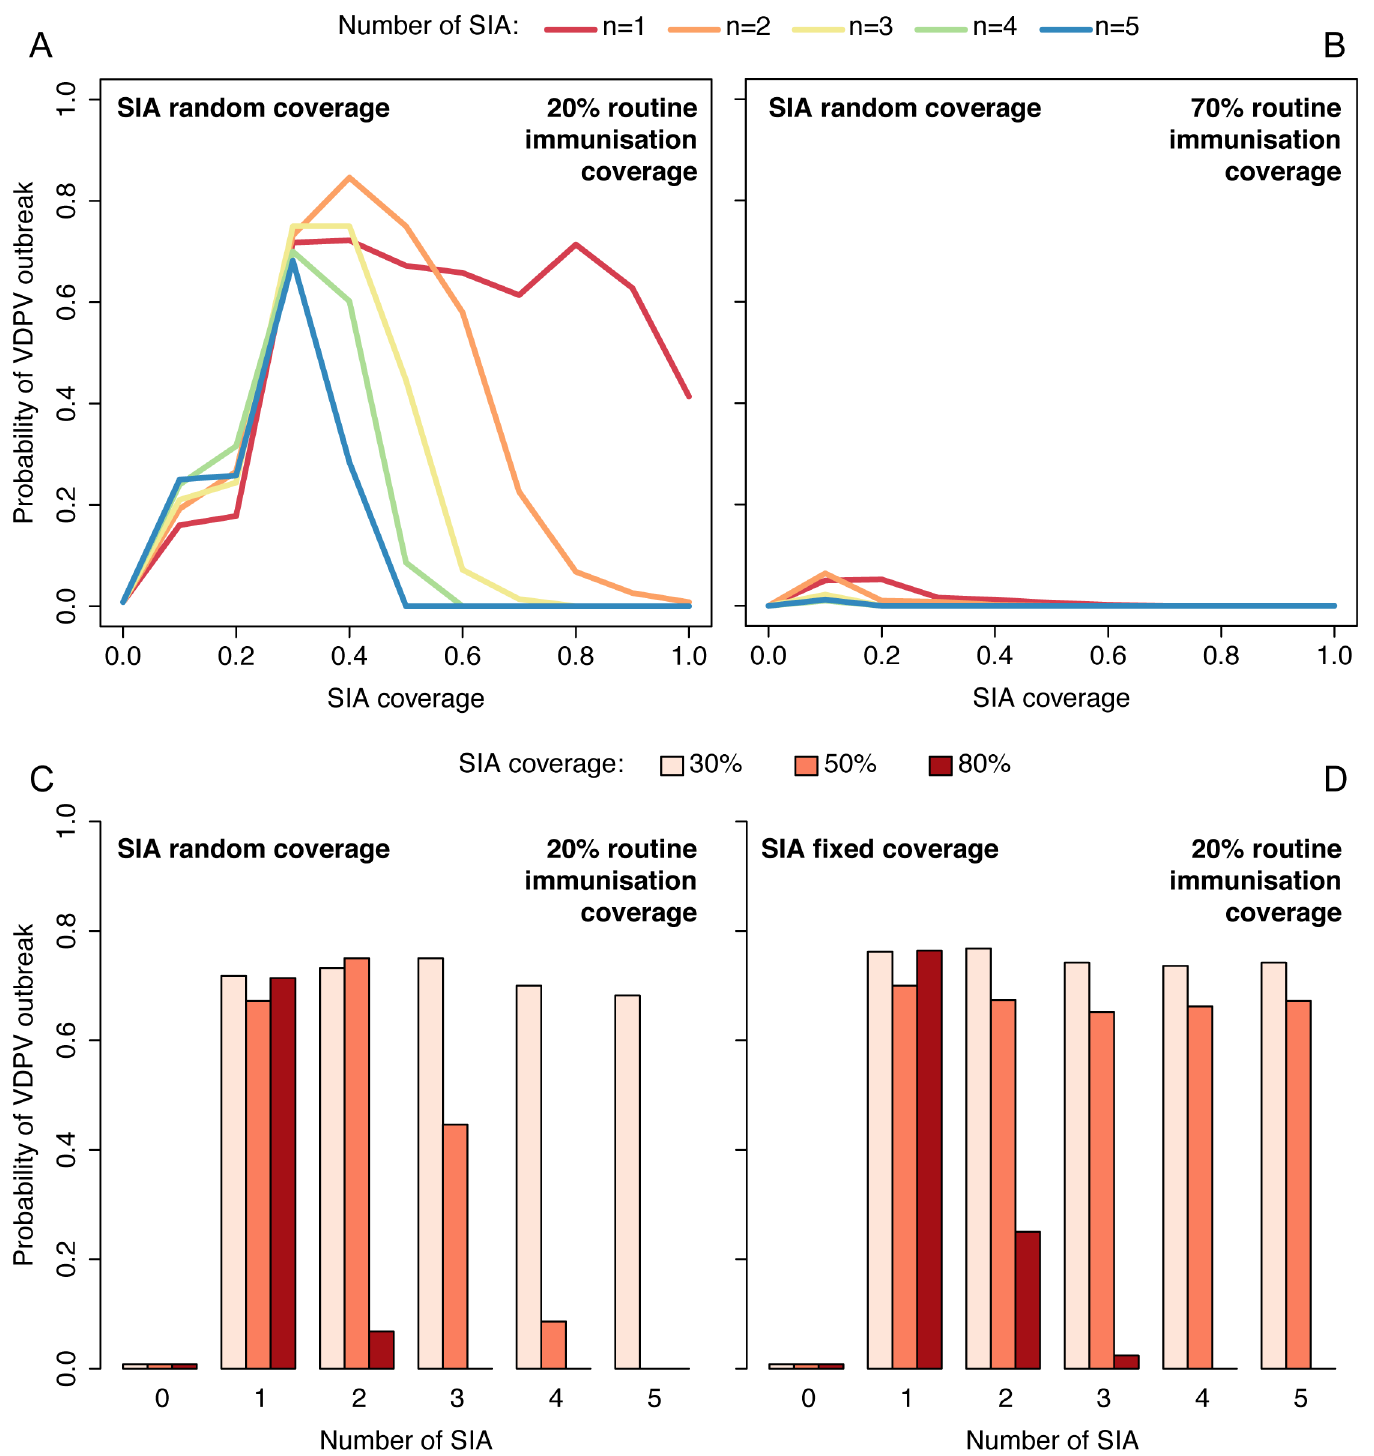
Fig 3. Probability of VDPV outbreak for scenarios with both routine immunisation and SIAs. Probability of a VDPV outbreak during the 6 months following OPV withdrawal as a function of SIA coverage for the stochastic dynamic model with routine immunisation and SIA random coverage, assuming (A) 20% and (B) 70% routine immunisation coverage. Probability of a VDPV outbreak in a setting with 20% routine immunisation coverage as a function of the number of SIAs, assuming they reach a fixed proportion of the population at each round consisting of (C) randomly chosen individuals each time (SIA random coverage) or (D) the same individuals each time such that there is a persistently “ missed ” group (SIA fixed coverage). The probabilities are based on 500 simulations of the model.